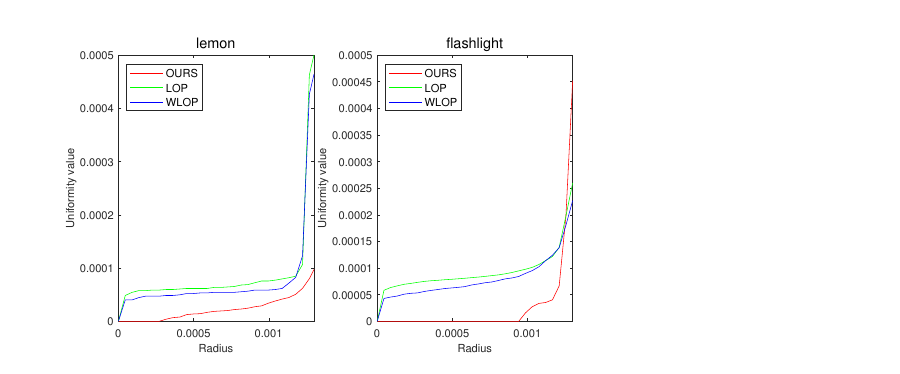
Figure 18. Quantitative result for real data sets. The first and second columns show the uniformity results of each algorithm for Lemon and Flashlight.